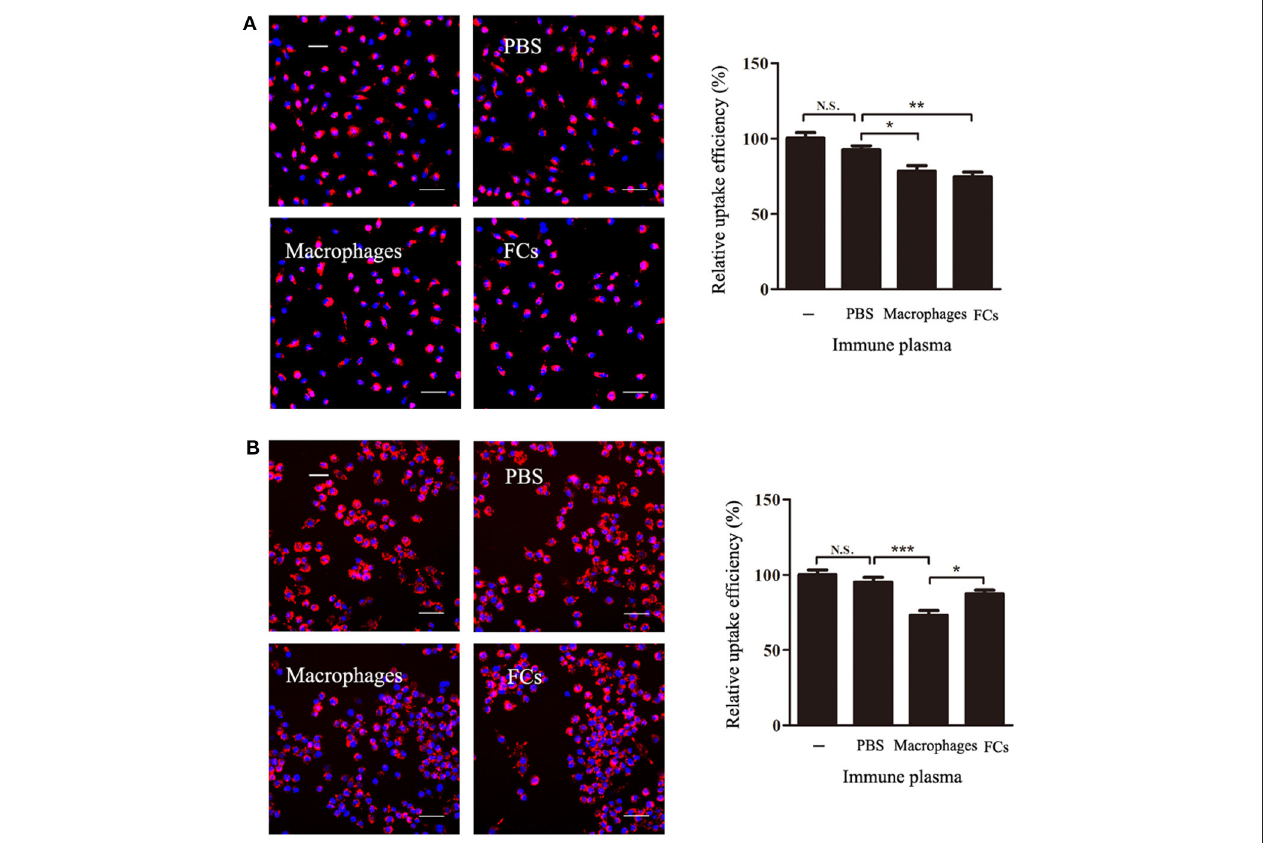
FIGURE 7 | FCs immune plasma blocks the process of FCs formation. (A) For the FCs formation inhibition study, the macrophages were incubated in duplicate with or without plasma (50 µ L/mL) from FC-immune ApoE − / − mice for 3h in the presence of DiI-oxLDL. (B) Further investigation of the effect of immune plasma on FCs formation. Macrophages were treated with or without plasma (50 µ L/mL) from PBS-immune, macrophages-immune, or FC-immune ApoE − / − mice for 1h. After washed, cells were cultured with 30 µ g/mL DiI-oxLDL for 3h (B) . Internalized oxLDL was revealed by DiI fluorescence, and six random fields per condition were captured by High Content Screening. A representative image is shown for each condition. Scale bars, 50 µ m. * p < 0.05; ** p < 0.01; *** p <